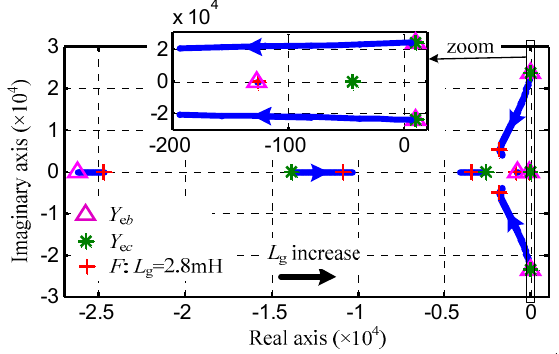
Figure 9. System E: pole maps of the two types of inverters and root locus of AN with grid impedance varying.